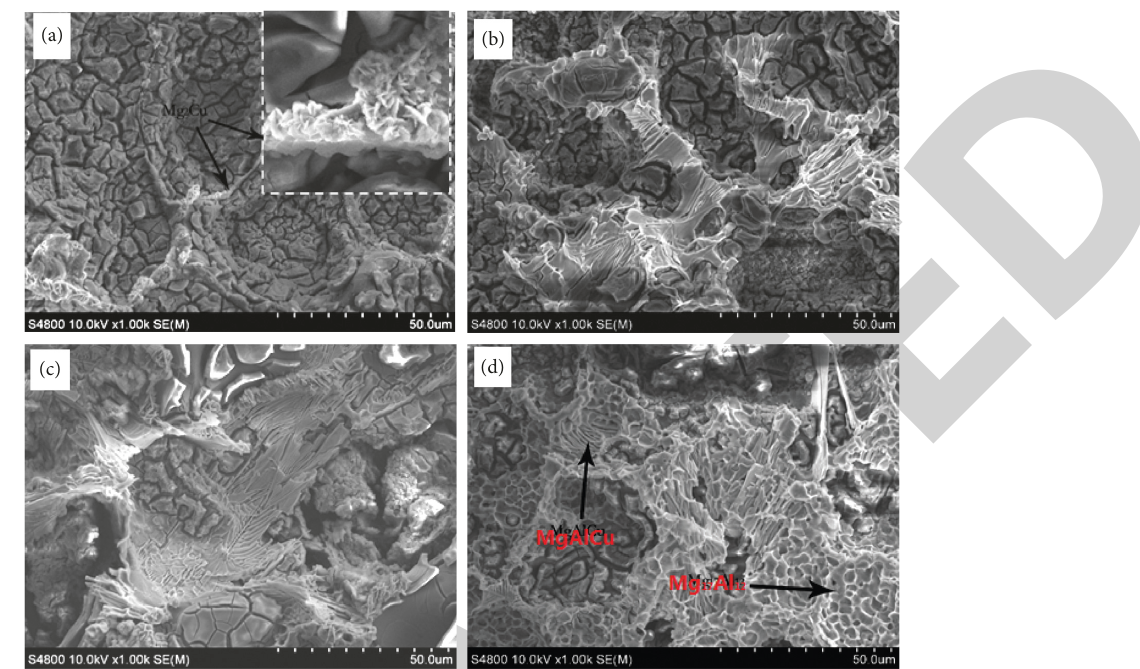
Figure 6: SEM micrographs after removing the degradation products: (a) AC02 alloy immersed for 2h, (b) AC32 alloy immersed for 4h, (c) AC52 alloy immersed for 4h, and (d) AC92 alloy immersed for 13 h in 3.5% NaCl solution. Table 2: Electrochemical parameter values of the alloys from Tafel